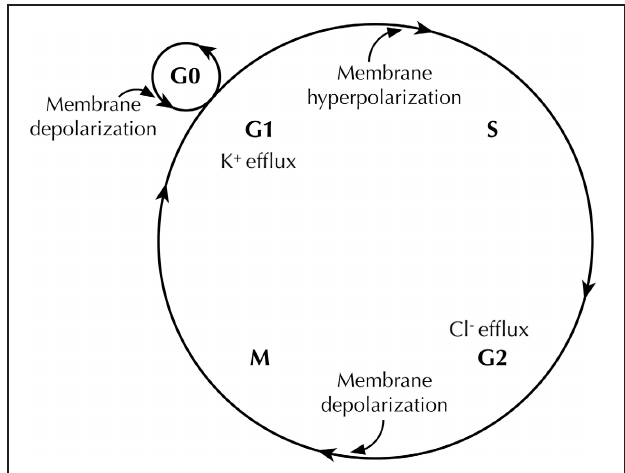
FIGURE 2 | Membrane potential ( V m ) changes during the cell cycle. V m undergoes hyperpolarization at G 1 /S border, by virtue of K + efflux through various K + channels. Before cells enter M phase, increased Cl − efflux accompanies V m depolarization. Quiescent cells at G 0 stage show mitotic activities after V m depolarization (Cone and Cone,